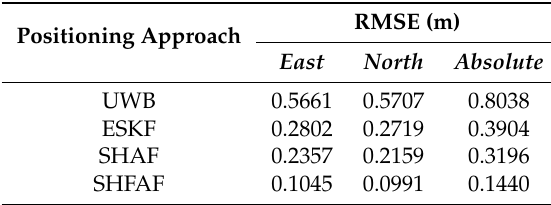
Figure 8. The simulation results in Scenario 2. ( a ) The positioning results that outliers with large errors exist in measurement data. ( b ) The absolute distance error of different integrated positioning approaches. Table 1. The root mean square error (RMSE) with different positioning